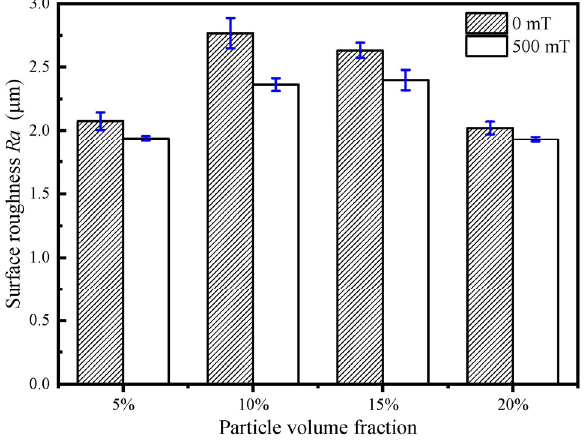
Fig. 13 The surface roughness of MRE with/without magnetic field.